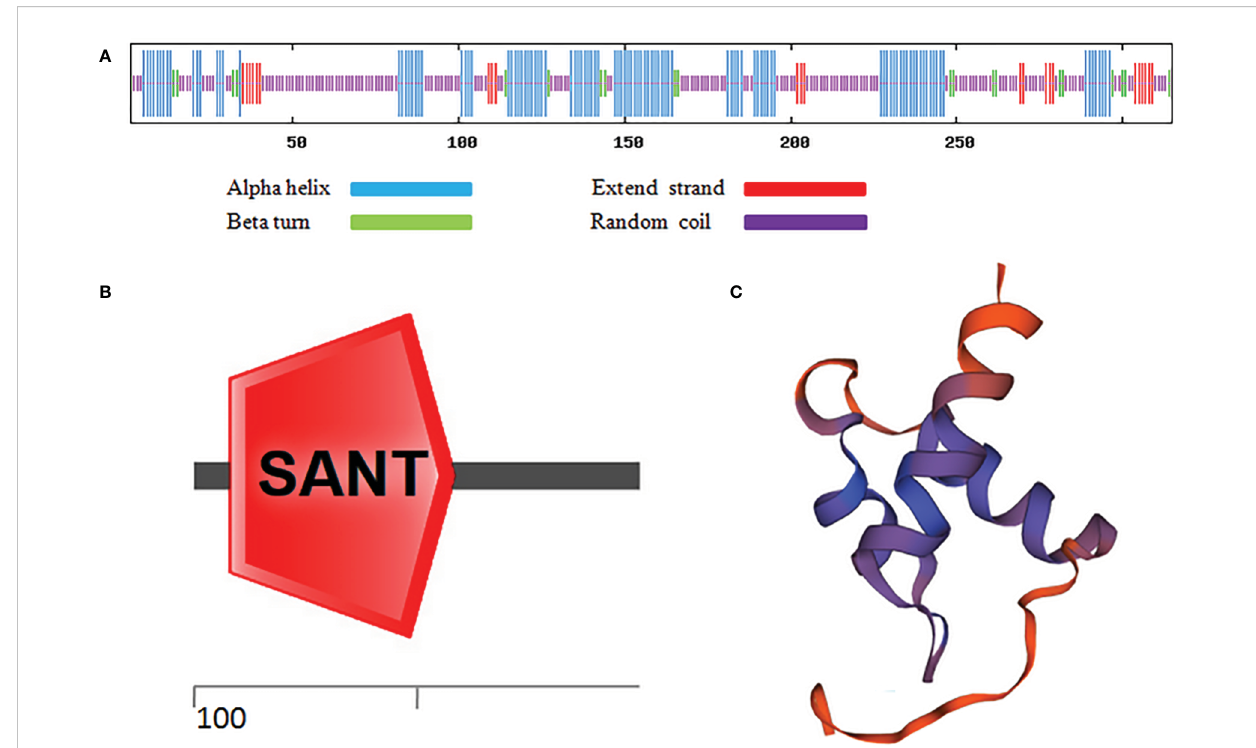
FIGURE 2 Prediction of Secondary and Tertiary Structure of MbMYBC1 Protein. (A) Predicted protein secondary structure; (B) predicted protein domains; (C) predicted tertiary